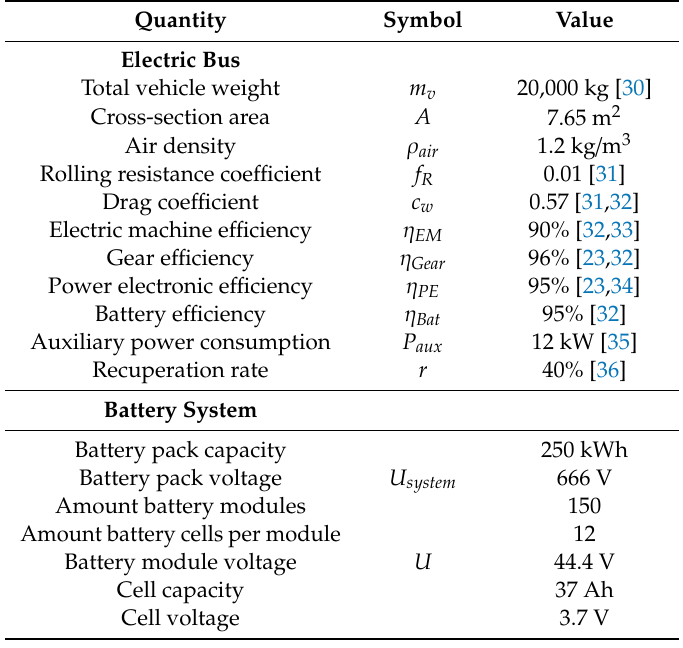
Table 2. Technical specifications of the electric bus and the battery